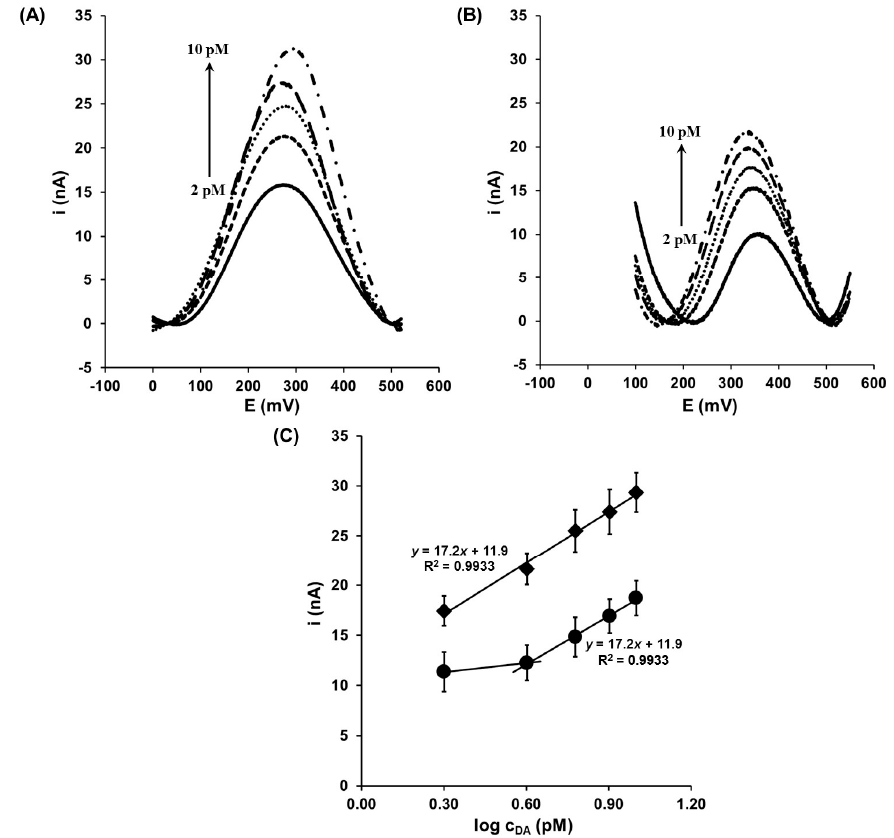
Figure 6. Representative OSWV responses of DA on the HSCX–COOH/MET modified gold electrode (concentration of DA from 2 to 10 pM) in the 0.2 M McIlvain buffer with ( A ) pH 2.0 and ( B ) pH 7.0; ( C ) The intensity of redox DA current vs. the logarithm from the concentration of DA measured with electrodes modified with HSCX–COOH/MET in the 0.2 M McIlvain buffer at ( ♦ ) pH 2.0 ( n = 5, 1.5 < standard deviation (SD) < 2.2) and ( ● ) pH 7.0 ( n = 5, 1.7 < SD < 2.0). The OSWV was performed with step potential 0.5 mV, square-wave frequency 10 Hz, and square-wave amplitude 25 mV.